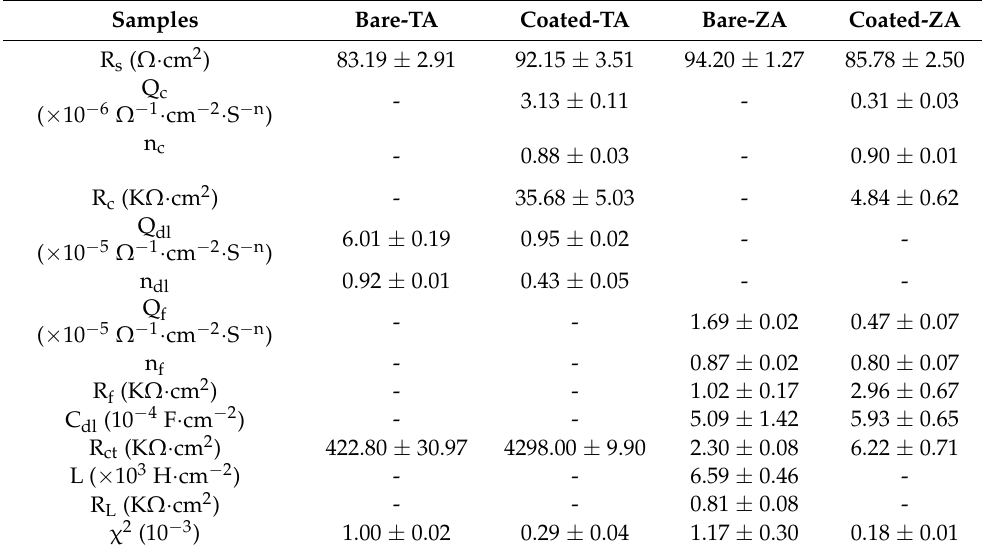
Table 3. EIS fitted parameters of the equivalent electrical circuits for bare and ZnP-coated TA and ZA samples. Values are shown as mean ± SD, n =